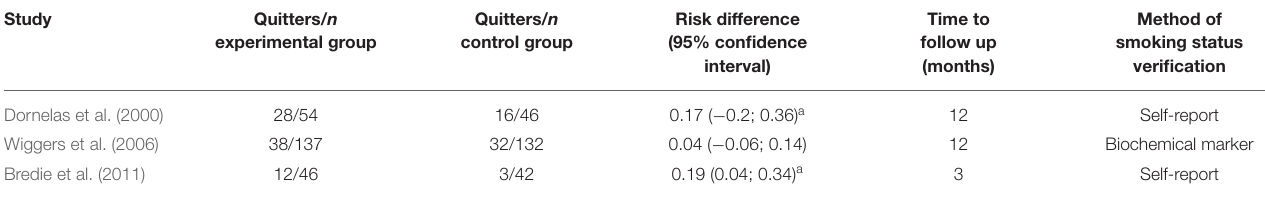
TABLE 1 | Overview of randomized trials of MI on smoking cessation in patients with CAD. Study